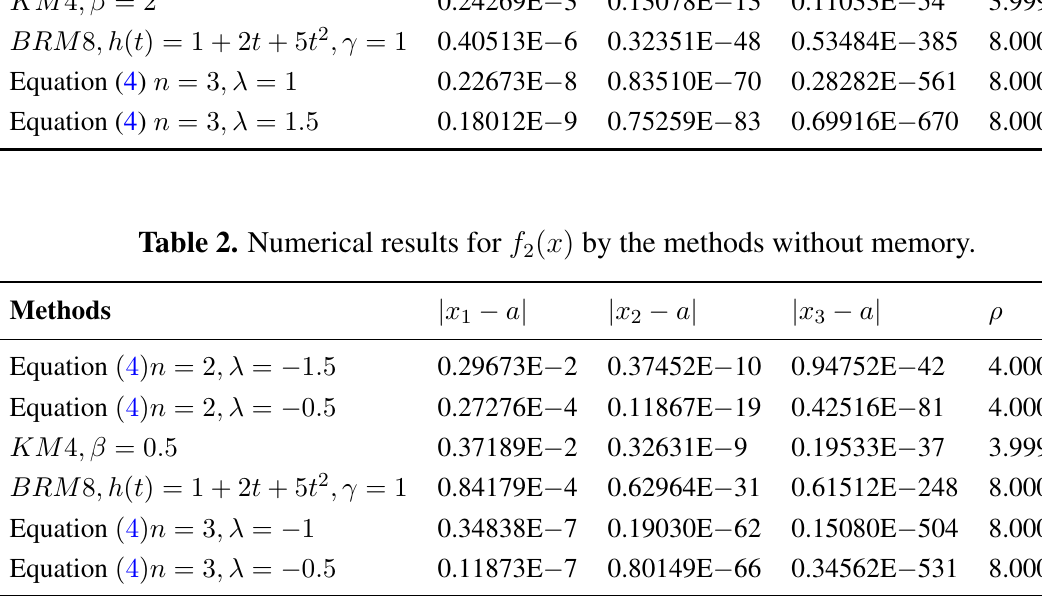
Table 3. Numerical results for f